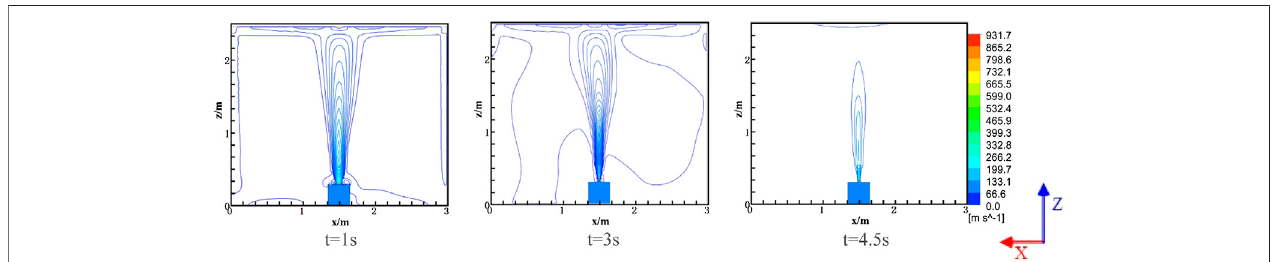
FIGURE 5 | Velocity contour in the XZ plane at y = 2.5 m.